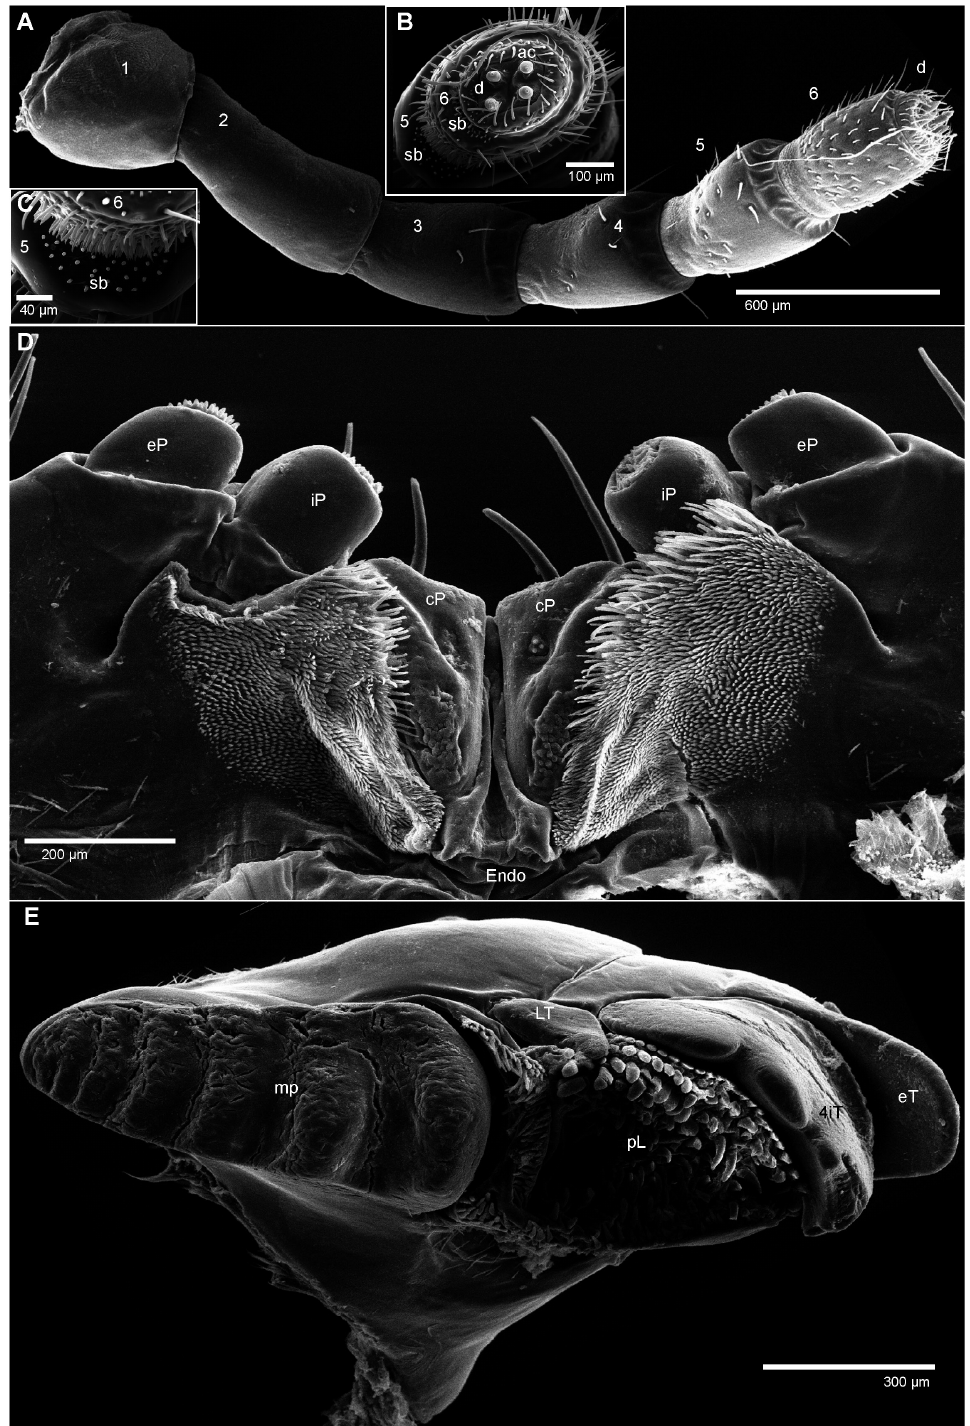
Fig. 2. Dichromatobolus elephantulus gen. et sp. nov., ♂ (ZFMK MYR9896), SEM. A . Right antenna. B . Disc, apical view. C . Border of antennomere 5 to 6 with sensilla basiconica. D . Gnathochilarium, internal surface. E . Left mandible, mesal view. Abbreviations: 4iT = four-combed inner tooth; ac = apical cone; cP = central pads; d = disc; Endo = endochilarium; eP = lateral palpus; eT = external tooth; iP = inner palpus; LT = lateral tooth; mp = molar plate; pL = pectinate lamellae; sb = sensilla bascionica; numbers refer to antennomere